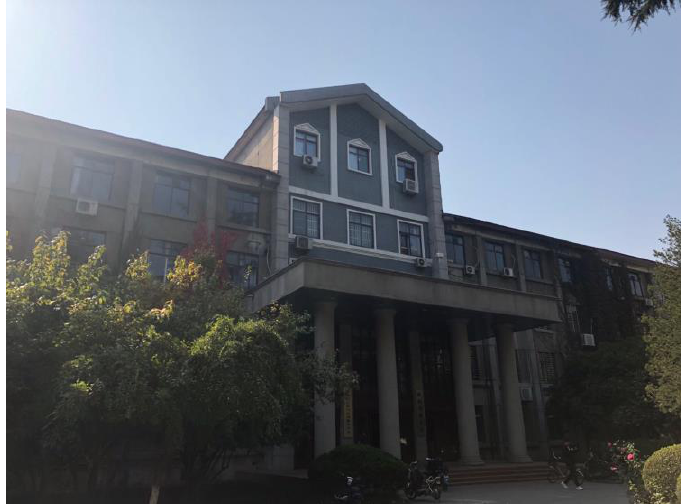
Figure 9. The cultural relics protection unit of Shaanxi Province.